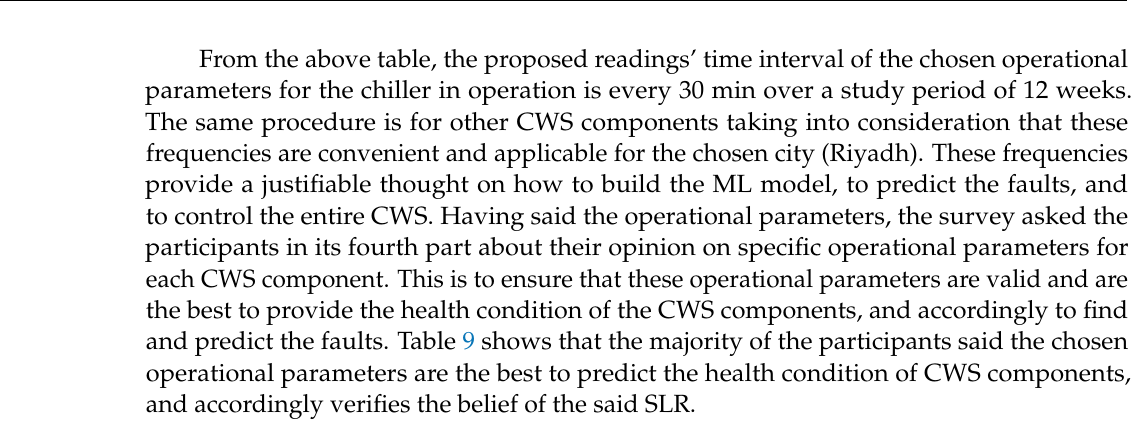
Table 9. Operational